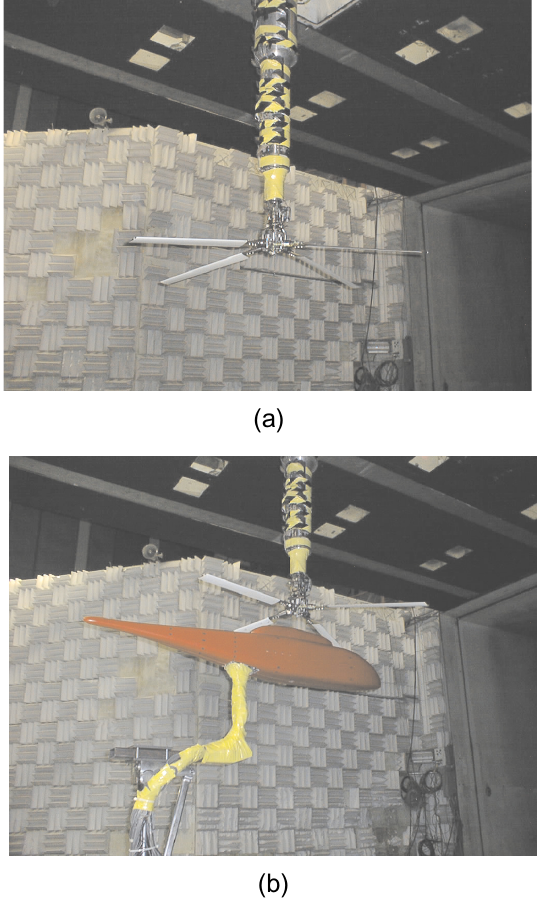
Fig. 6. (a) Isolated Rotor Test System, IRTS, and (b) IRTS + fuselage. Table 1 Rotor and tunnel conditions corresponding to the seven flight conditions addressed in this paper.